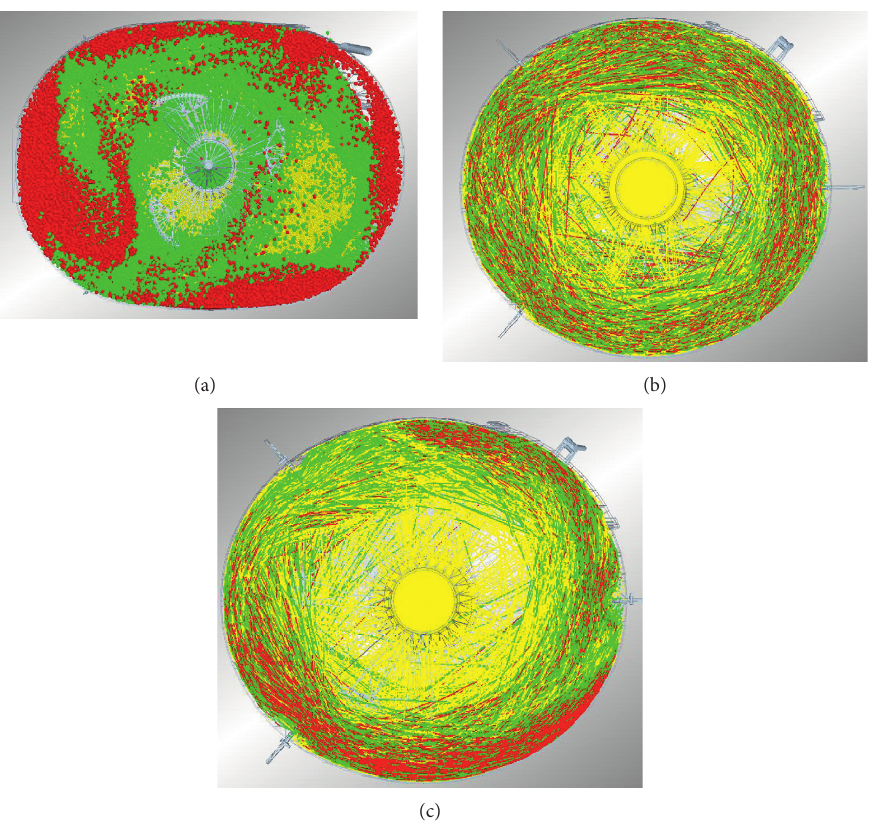
Figure 15: Radial material flow in the bin at different auger speeds: (a) 15rev · min − 1 ; (b) 25rev · min − 1 ; and (c) 35rev · min − 1 .